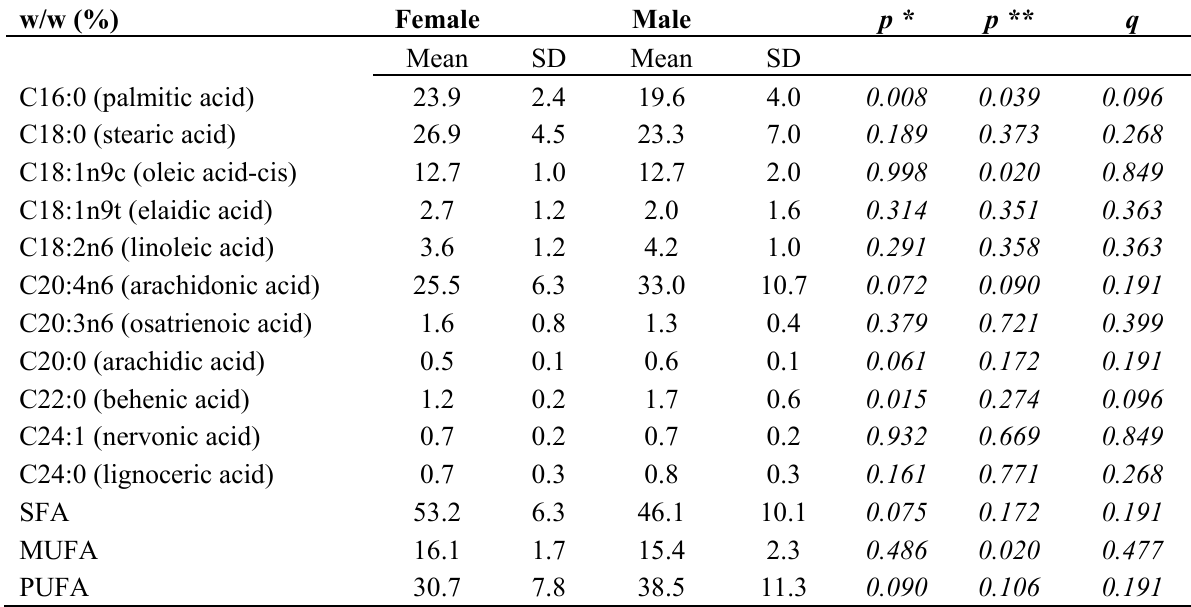
Table 5. Fatty acids profile of PBMC in female and male subjects (Study 2).